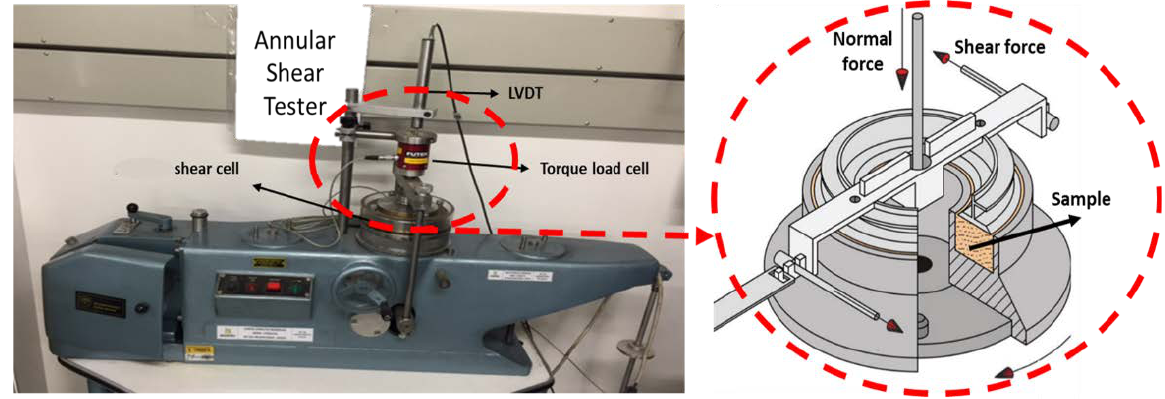
Figure 3. Annular shear strength test. Adapted from [18].